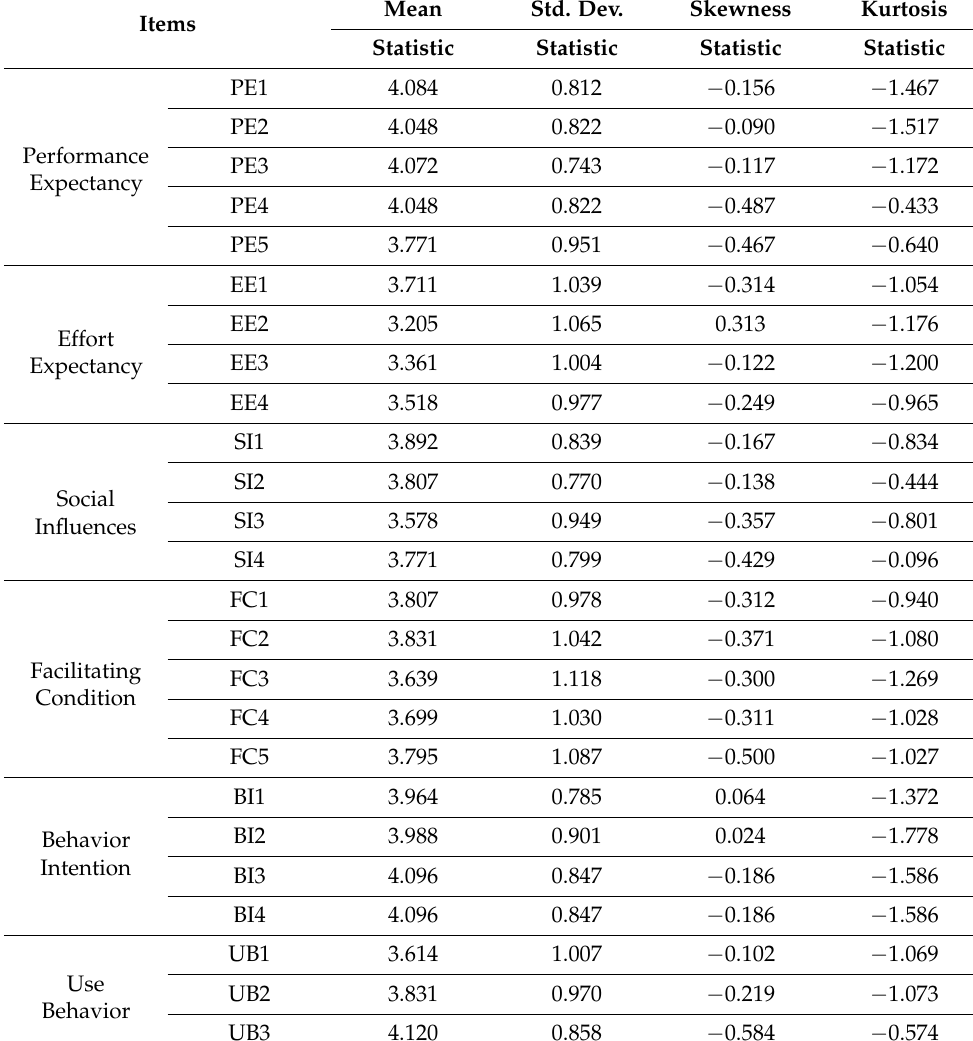
Table 3. Descriptive